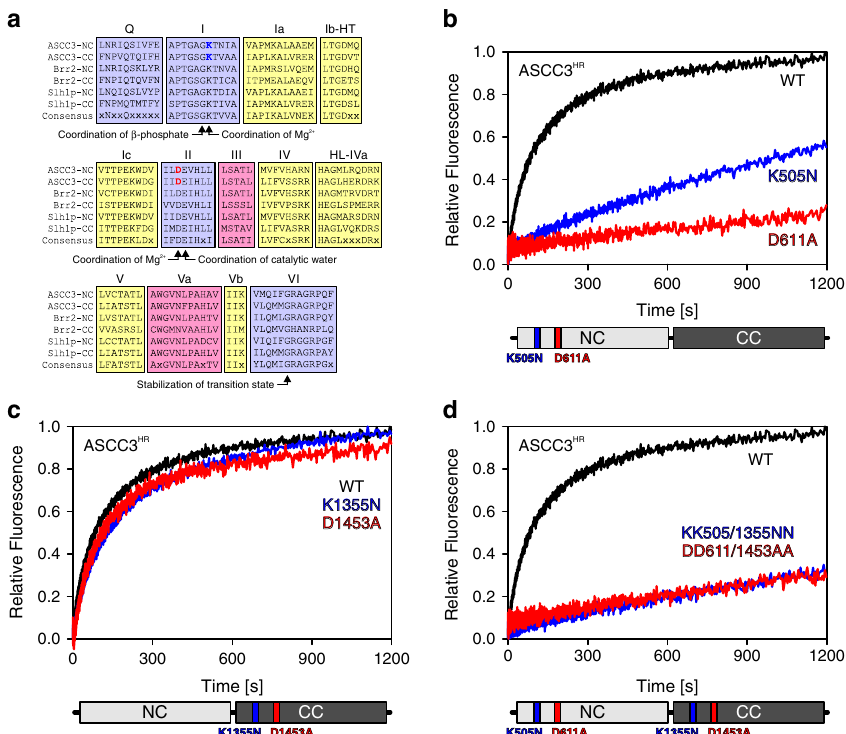
Fig. 6 Mutational analysis. a Multiple sequence alignment of conserved helicase motifs (indicated by letters or Roman numerals above the alignment) in human ASCC3, human Brr2 and yeast Slh1p N-terminal cassettes (NC) and C-terminal cassettes (CC). The conserved motif I lysine and motif II aspartate residues of ASCC3 cassettes, which were altered in the present analysis, are highlighted in blue and red, respectively. Color coding of the motifs: involved in ATP binding, blue; involved in RNA binding, yellow; involved in communication of RNA binding and ATPase activities, red. Roles of selected residues are indicated below the alignment. b – d Stopped- fl ow/ fl uorescence-based assays monitoring unwinding of 3 ’ -overhang DNA by the indicated ASCC3 HR variants using ATP. Schemes below the unwinding traces represent ASCC3 HR with altered residues highlighted. WT/K505N/D611A/K1355N/D1453A/ KK505/1355NN/DD611/1453AA, ASCC3 HR variants as de fi ned in the